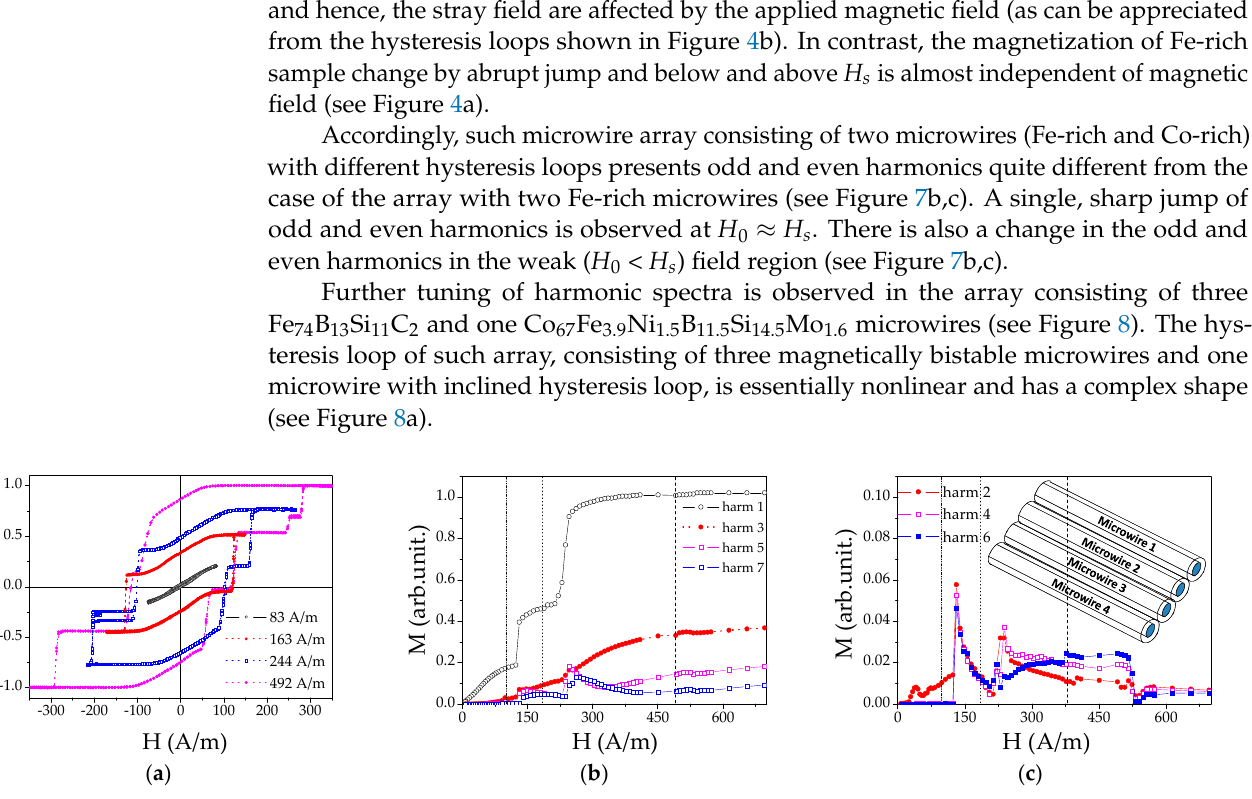
Figure 7. ( a ) Hysteresis loops of the Fe 74 B 13 Si 11 C 2 ( d = 19.4 μ m) + Co 67 Fe 3.9 Ni 1.5 B 11.5 Si 14.5 Mo 1.6 array; ( b ) dependences of odd harmonics on magnetic field amplitude and ( c ) dependences of even harmonics on magnetic field amplitude. The schematic picture of the microwires array is provided in the inset of ( c ). Reprinted with permission from [50].